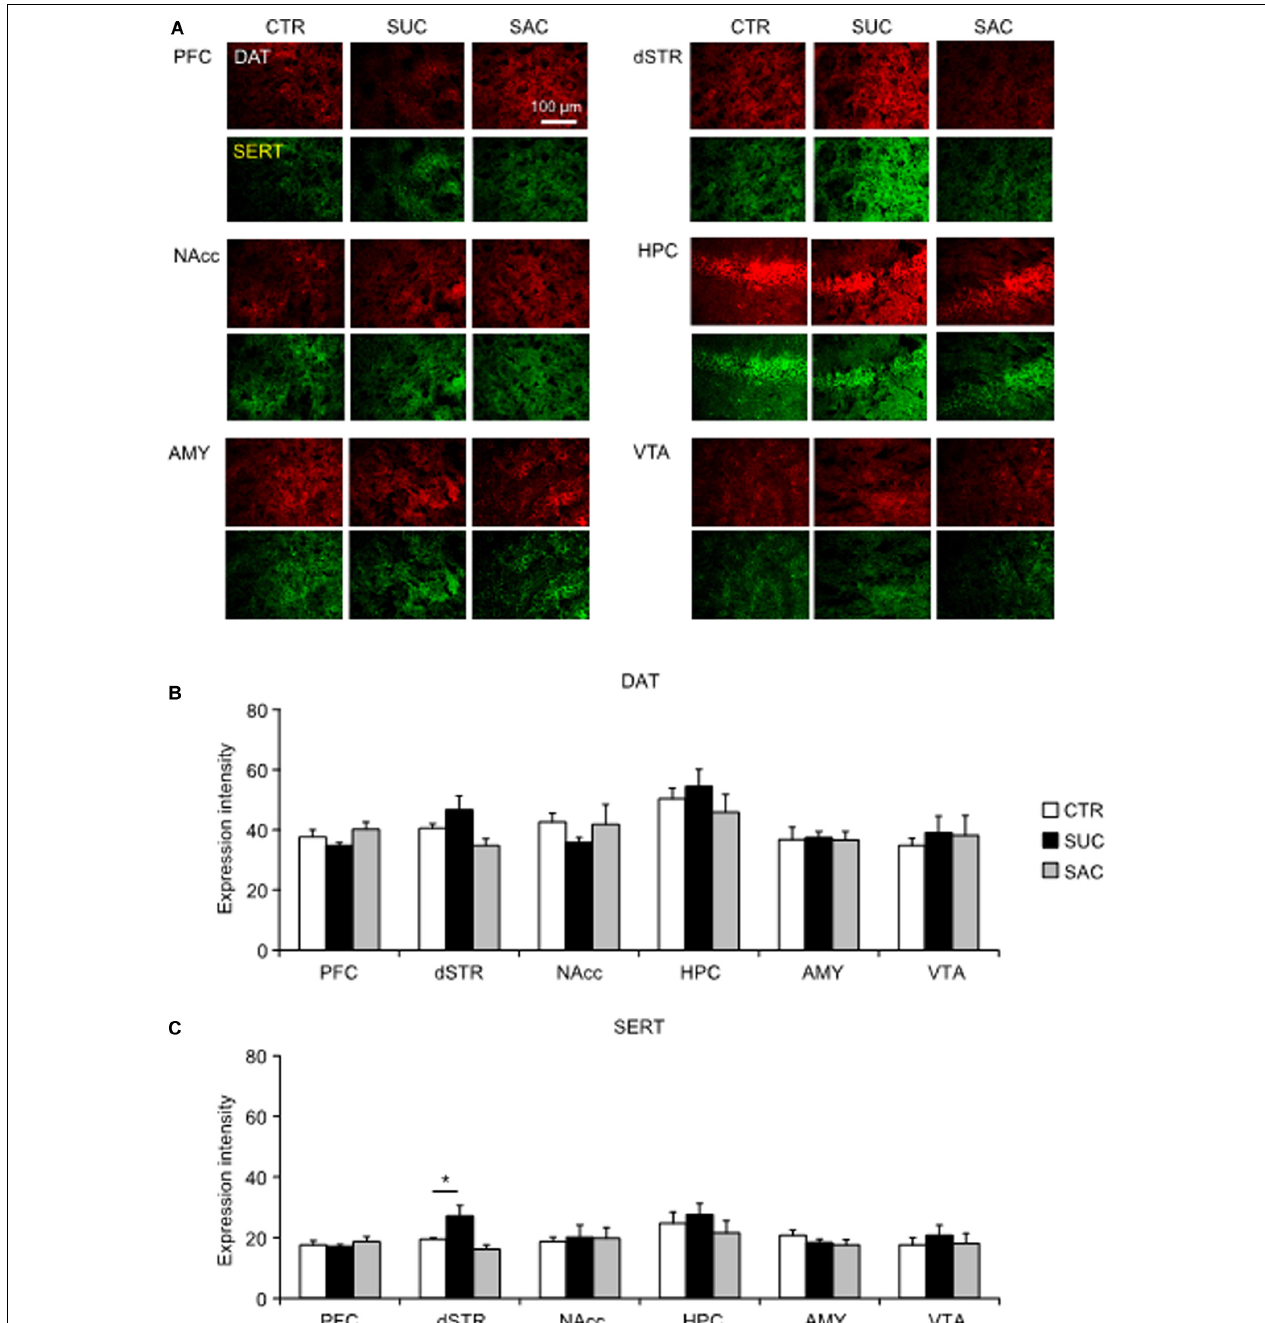
FIGURE 5 | Alterations of dopamine and serotonin transporter expression levels in mesocorticolimbic regions of juvenile animals subjected to sucrose and saccharine treatments. (A) Representative images of DAT (red) and SERT (green) expression levels in mesocorticolimbic regions of juvenile animals. Graph showing fluorescence intensities of DAT (B) and SERT (C) expression in juvenile animals. * p < 0.05.